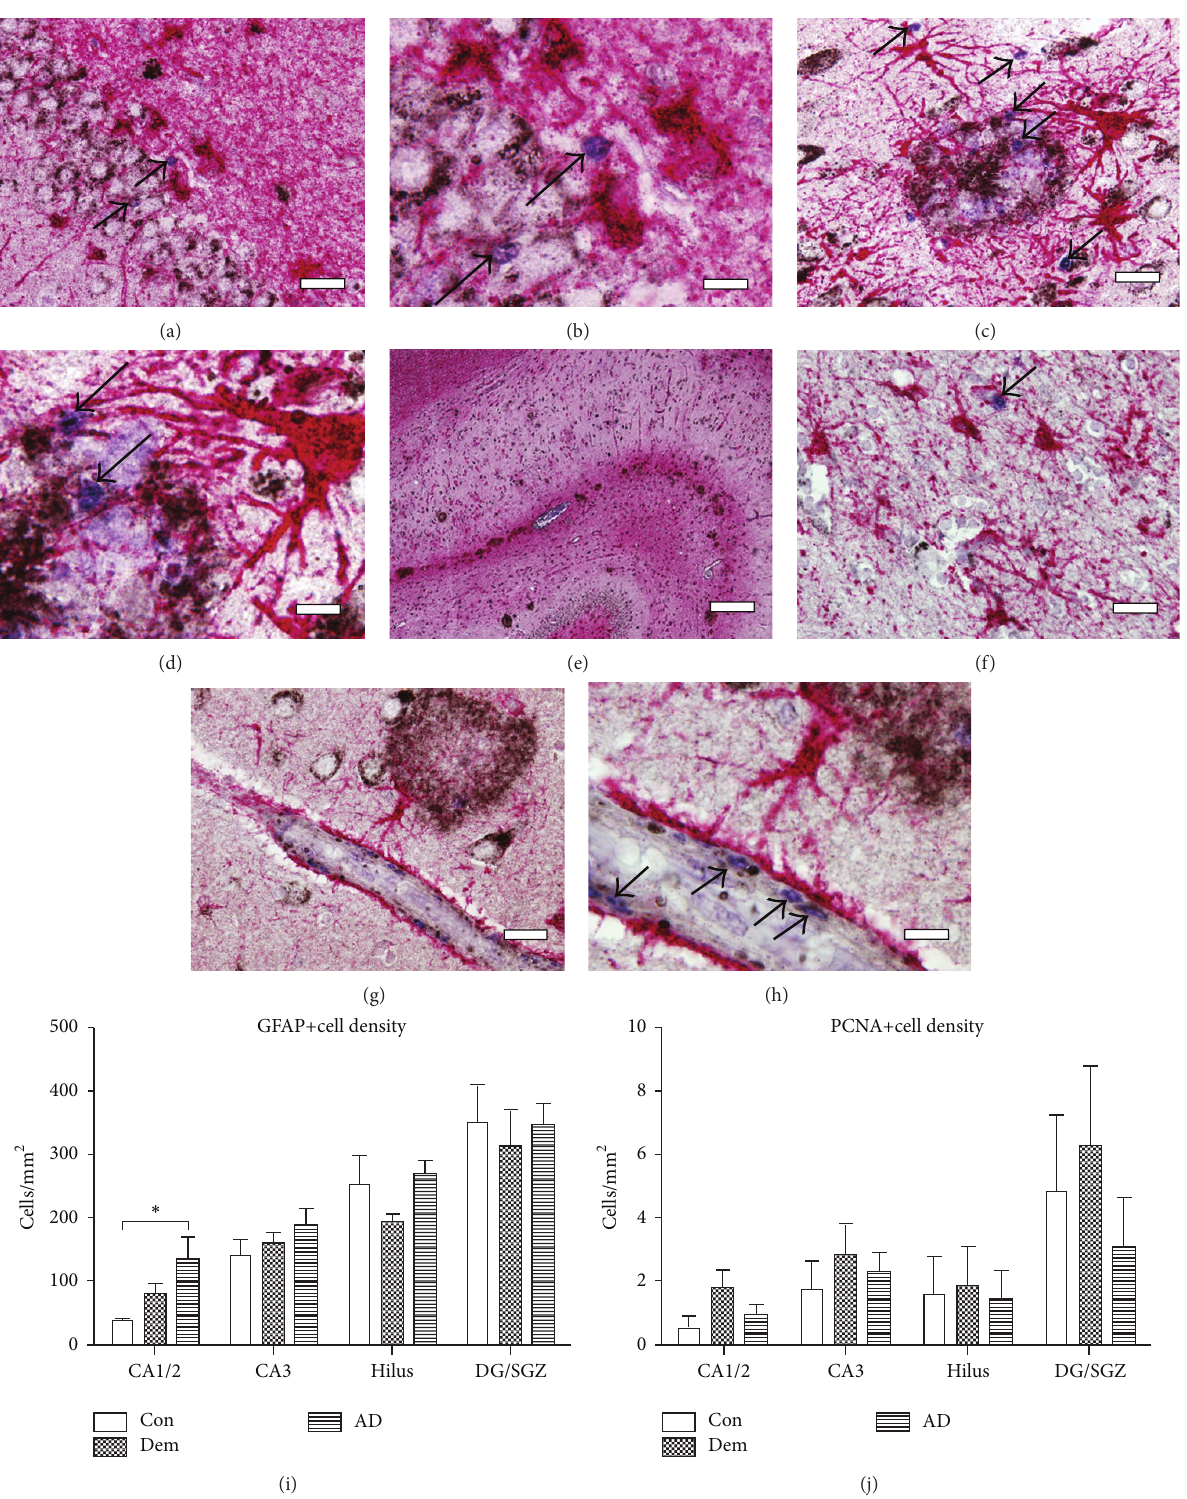
Figure 1: GFAP and PCNA expression in the human hippocampus (a, b) Immunolabeled GFAP+ (red) and PCNA+ (blue) cells did not colocalize in the SGZ or other areas of the hippocampus. (c-d) PCNA+ cells (arrows) were observed in the presence of hypertrophic astrocytes with processes infiltrating A 𝛽 plaques (black). (e) A low-magnification image representative of GFAP and A 𝛽 plaques distributed through out the CA areas, with heavy immunostaining in the stratum moleculare and stratum lacunosum. (f) PCNA+ cells were also found in glia-rich regions in the absence of A 𝛽 plaques and in blood vessels (g, h) outlined by astrocytic endfeet. (i) GFAP+ cells were found at higher density in the CA1/2 region in the AD versus control subjects (one-way ANOVA 𝑃 < 0.001 ). (j) PCNA+ cell density was not significantly different between patient cohorts. Scale bars: left panels (a, c, g) = 50 𝜇 m, panel (e) = 500 𝜇 m. Right panels (b, d, h) = 20 𝜇 m, panel (f) = 50 𝜇